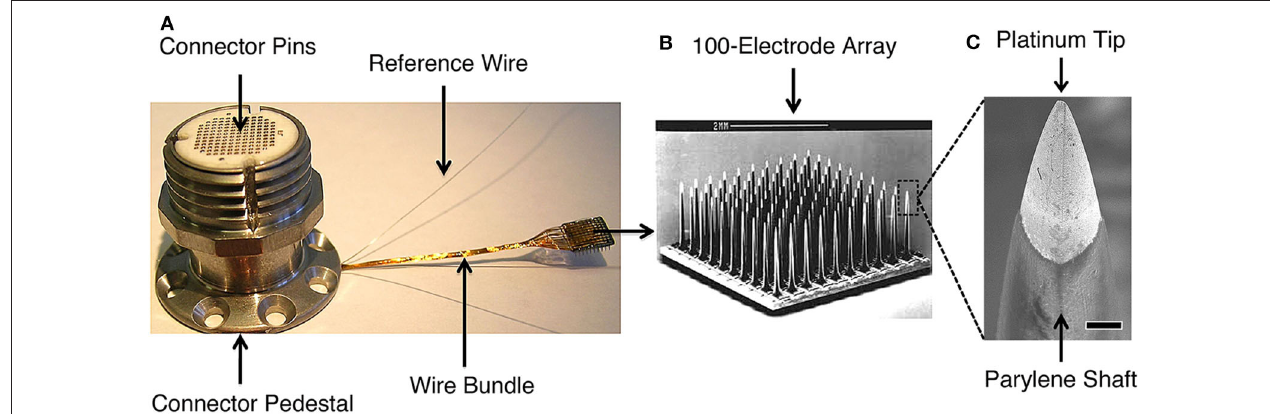
FIGURE 1 | The Blackrock Microsystems (Salt Lake, UT) silicon-based, Utah microelectrode array used in high performance intracortical brain-machine interface trials (e.g., Wodlinger et al., 2015; Pandarinath et al., 2017; Bockbrader et al., 2019). (A) Skull-mounted titanium pedestal with the wire bundle connected to a Utah MEA. The pedestal connector pins interface with an analog or digital headstage that transmits signals to the data acquisition system. (B) Scanning electron microscopy (SEM) image of the 10x10 array (scale bar is 2mm). (C) SEM of platinum-coated silicon tip and parylene-coated silicon shaft of a MEA electrode (scale bar is 10 µ m). MEA signals may be disrupted, e.g., by biologic tissue reactions around the electrode tips, deterioration of electrode materials, or mechanical connection failures. Detection methods can leverage the characteristic manner in which disruptions affect recorded signals, allowing for targeted interventions to restore signal quality and BMI function. Figure reprinted with permission from Barrese et al. (2016). © IOP Publishing. All rights